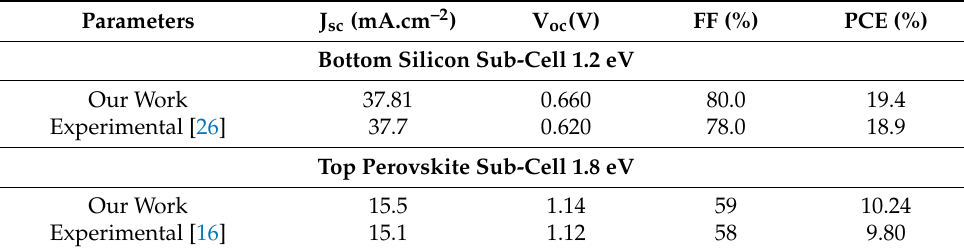
Table 2. Numerical (current work) and experimental photovoltaic parameters for the top and the bottom sub-cells considered in standalone conditions with the parameters and thicknesses reported in the literature and listed in Table 1.